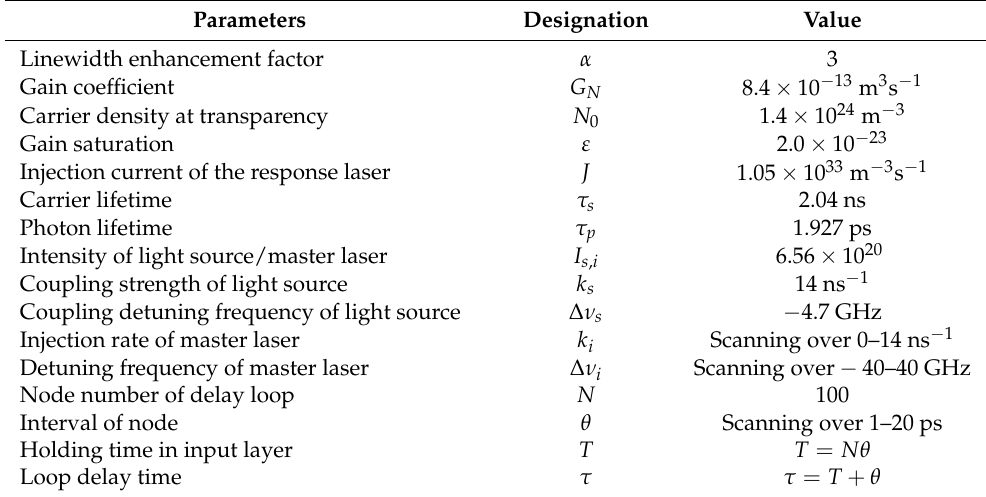
Table 1. Values of laser parameters. Parameters